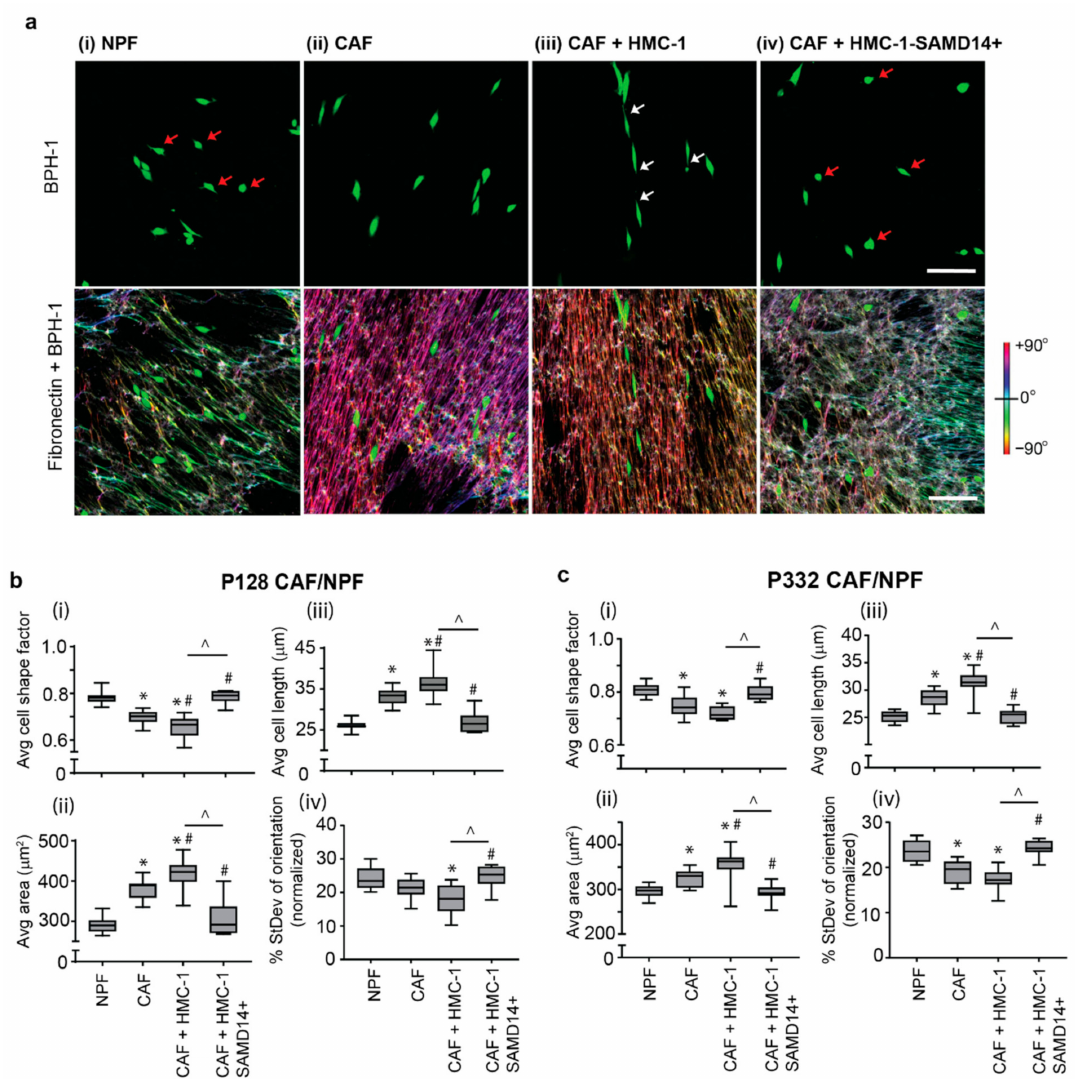
Figure 5. SAMD14 overexpression in mast cells reduces pro-tumor prostate epithelial morphology. ( a ) Representative images show BPH-1 cell morphology when cultured with fibroblasts (CAF/NPF) derived from P128. Corresponding fibronectin staining after image processing to represent the degree of ECM fiber alignment produced by (i) NPF (from left), (ii) CAF, (iii) CAF + HMC-1 and (iv) CAF + HMC-1-SAMD14+ CM. Scale bar: 100 µ m. ( b ) Quantification of (i) shape factor, (ii) area, (iii) cell length and (iv) standard deviation of orientation of BPH-1 cells cultured on NPF, CAF, CAF + HMC-1 CM and CAF + HMC-1-SAMD14+ CM (P128) after 24 h of co-culture. Box and whisker plots represent the max to min value of BPH-1 shape factor, area, cell length and standard deviation of orientation. ( c ) Quantification of (i) shape factor, (ii) area, (iii) cell length and (iv) standard deviation of orientation of BPH-1 cells on NPF, CAF, CAF + HMC-1 CM and CAF + HMC-1-SAMD14+ CM (P332) after 24 h of co-culture. Box and whisker plots represent the max to min value of BPH-1 shape factor, area, cell length and standard deviation of orientation. Graphs represent analysis of 3 images per replicate and 4 replicates are conducted per patient (>50 BPH-1 cells/image). Statistics performed using two-way ANOVA with Tukey’s post hoc test for average shape factor, area and cell length (* = p < 0.0001 compared to NPF; # = p < 0.005 compared to CAF; ˆ = p < 0.0001 compared to CAF+ HMC-1) and a one-Way ANOVA with Tukey’s post hoc for average standard deviation of orientation (* = p < 0.001 compared to NPF; # = p < 0.05 compared to CAF; ˆ = p < 0.001 compared to CAF+ HMC-1). Quantitation of morphological cell parameters showed that when cultured with CAF,